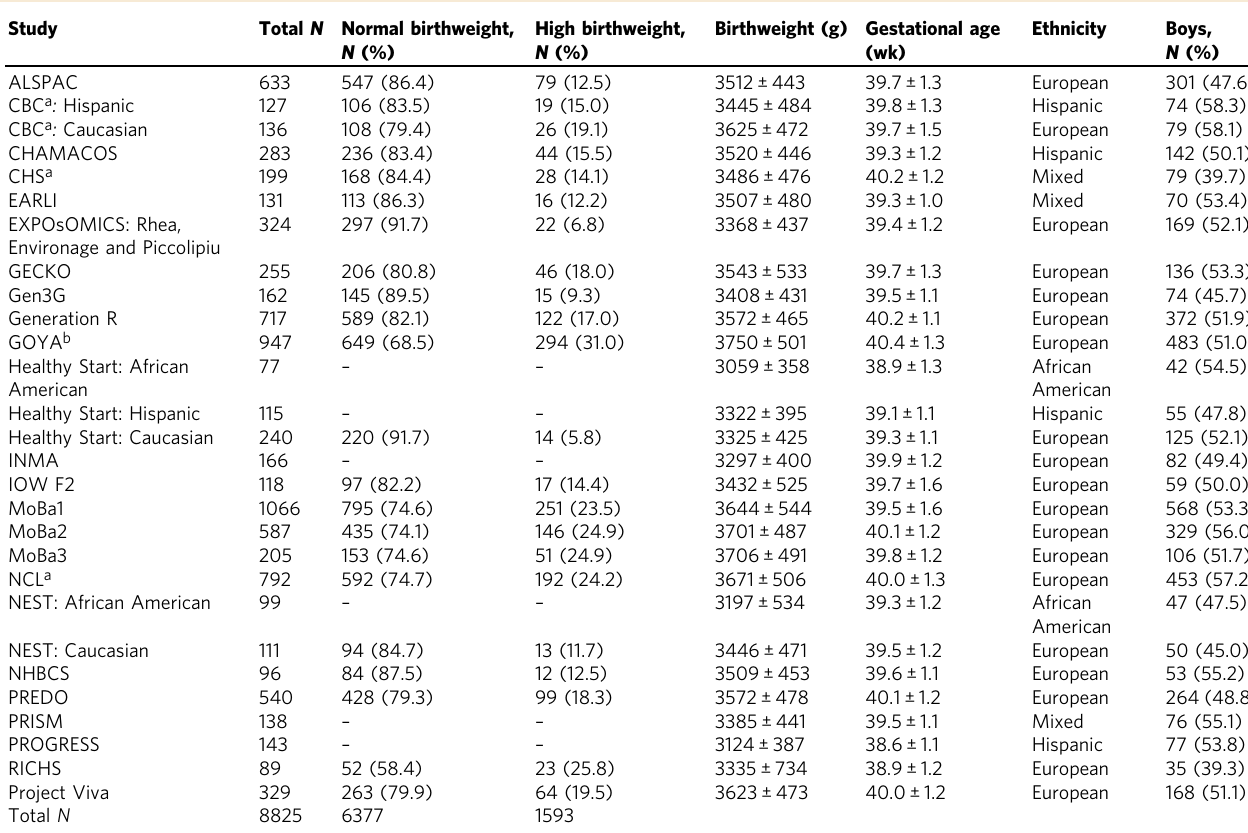
Table 1 Characteristics for the participating studies in the main meta-analysis for the association between neonatal blood DNA methylation and birthweight Study